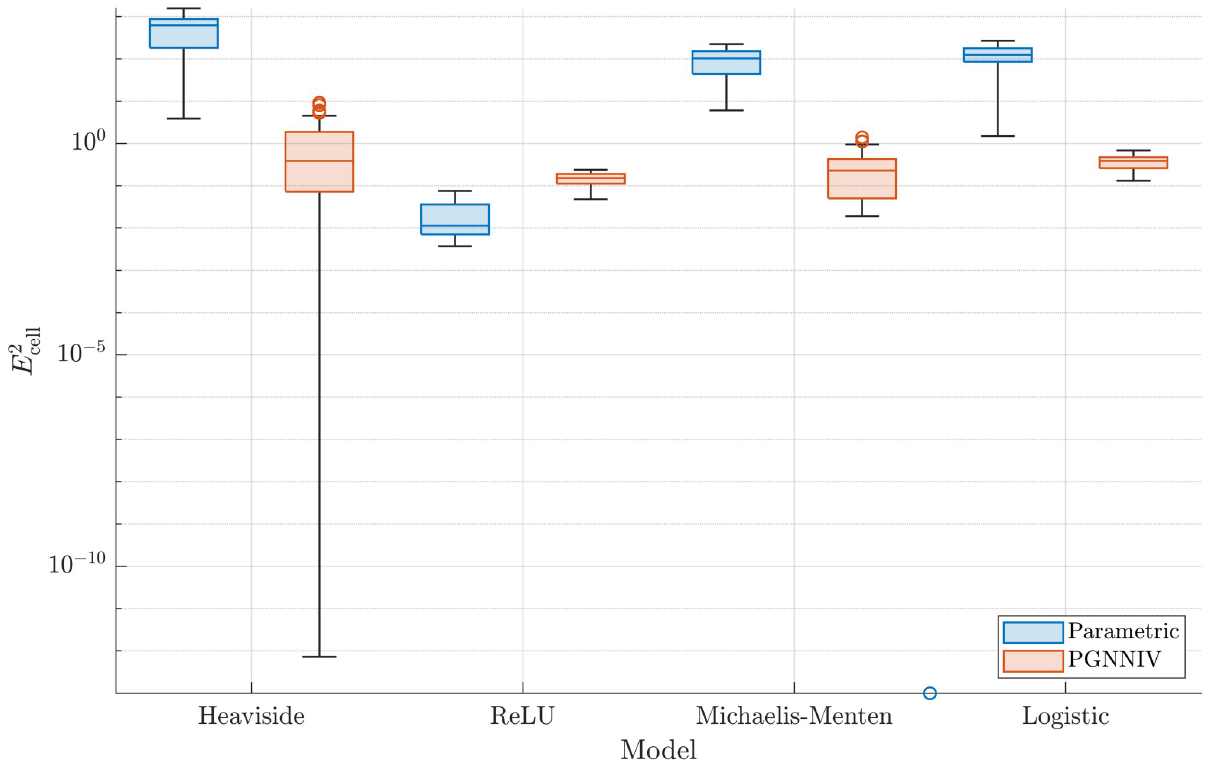
Fig 7. Prediction error. The non-parametric model built using the PGNNIV approach is able to correctly estimate the cell profile evolution for any arbitrary model better than specific parametric ones. The predictions are more accurate (lower error) and more precise (lower variability) along with the different tested boundary